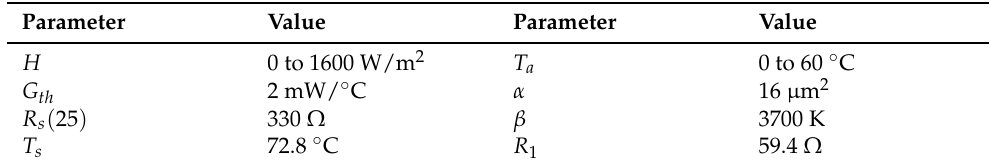
Table 2. CT parameters used in